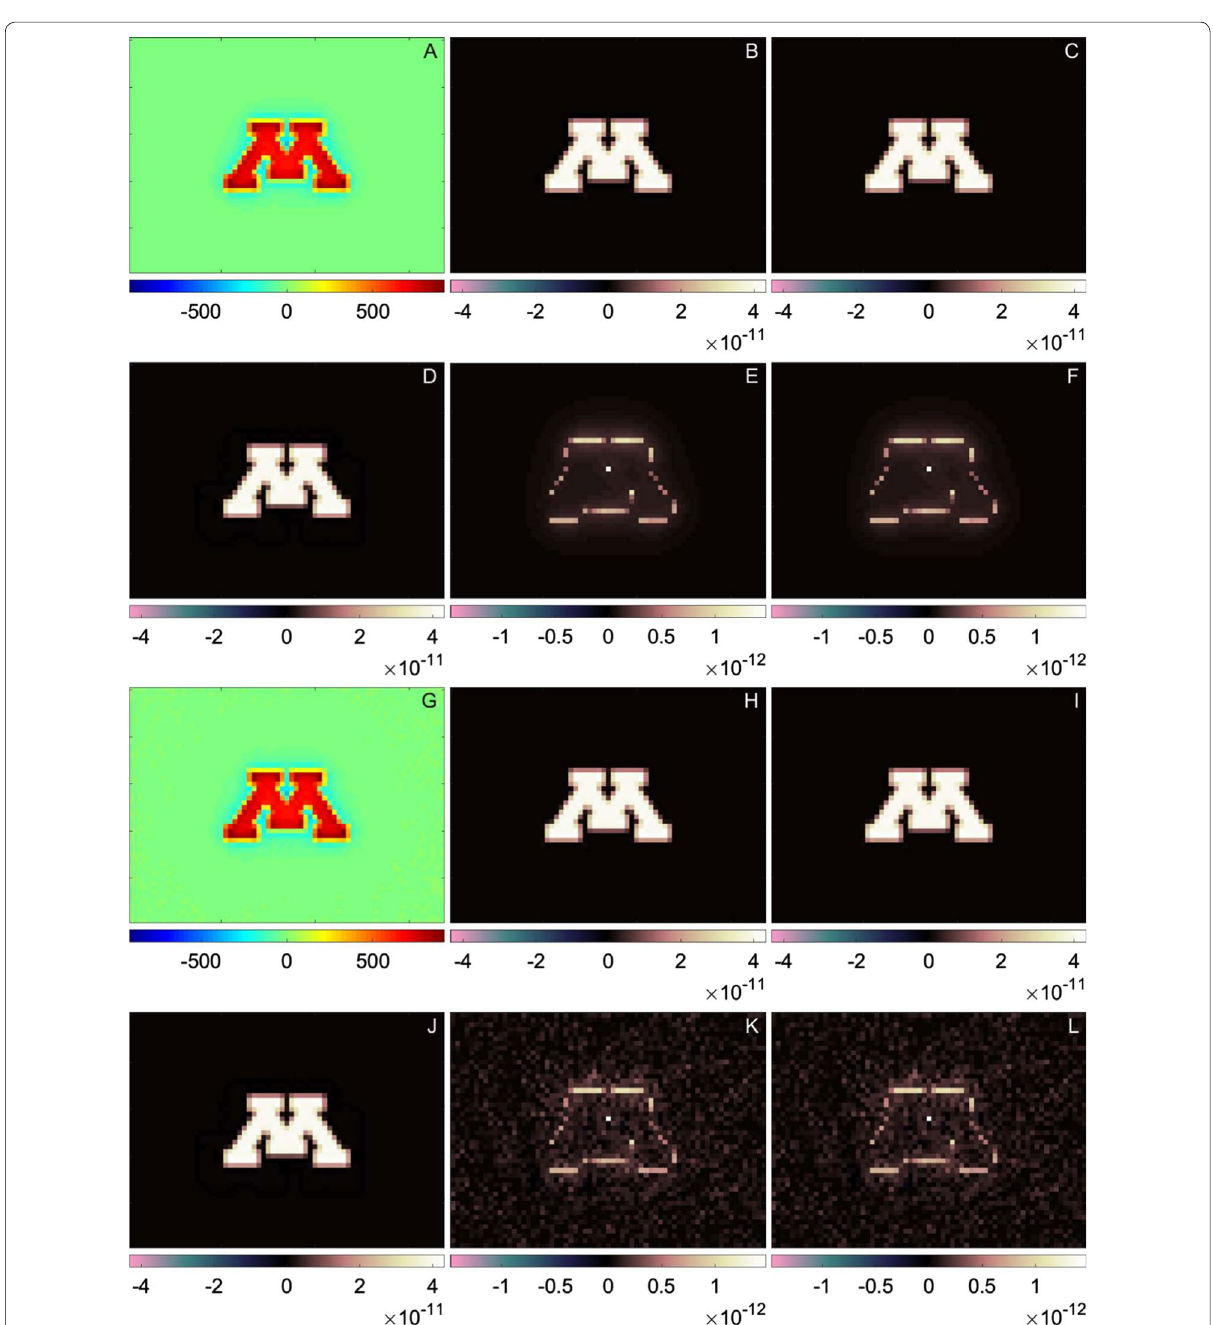
Fig. 3 Comparison of SIRM magnetic sources for synthetic MM data of the UMN logo for scenarios 3 ( a – f ) and 4 ( g – l ): a , g simulated synthetic SIRM B z field in nT calculated from the UMN logo, b , h inverted magnetic sources from the TNT-NN method, c , i inverted magnetic sources from the LH-NNLS method, d , j known magnetic sources used to produce the synthetic MM scan (negative values are difficult to discern as their magnitudes are approximately an order of magnitude less than the positive values), e , k difference between the TNT-NN and known solutions, f , l difference between the LH-NNLS and known solutions. The field of view for each image is 6.7 mm × 5 mm, dipole orientation is out of page, and the units of b – f and h – l are Am